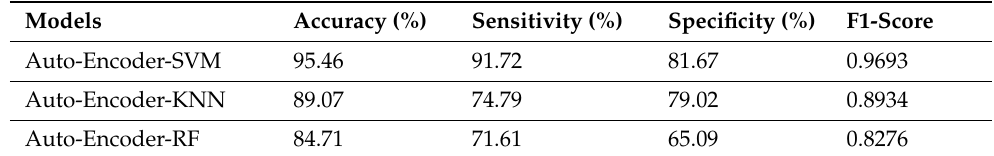
Table 4. Performance parameters of